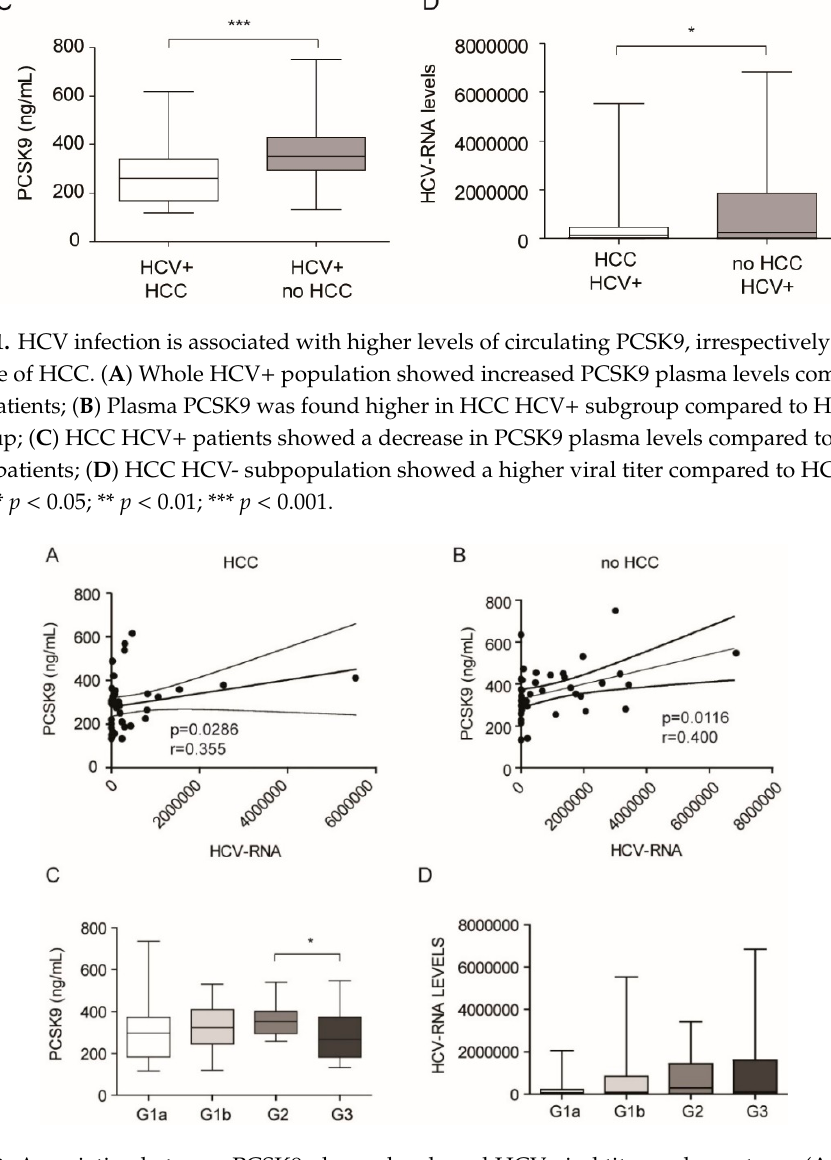
Figure 2. Association between PCSK9 plasma levels and HCV viral titer and genotype. ( A , B ) linear regression analysis, with a 95% confidence interval, between PCSK9 levels and HCV viral titer in HCC ( A ) and no HCC patients ( B ). ( C ) PCSK9 levels in different HCV genotypes. ( D ) Viral titer levels between HCV genotypes. * p < 0.05.